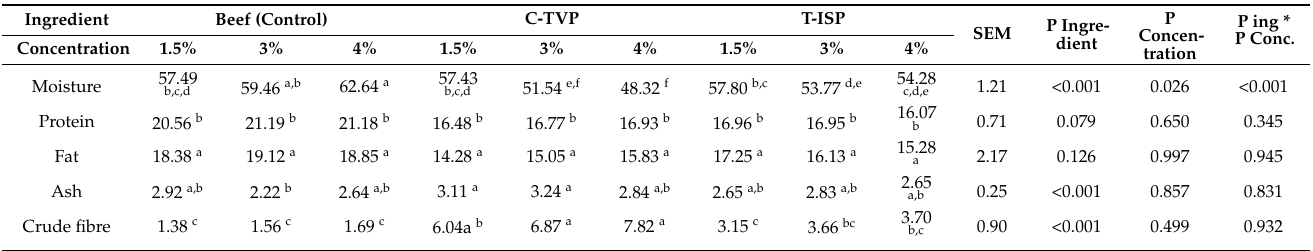
Table 2. Proximate chemical composition of plant-based meat and control (beef) with different concentration of methylcellulose. Ingredient Beef (Control)